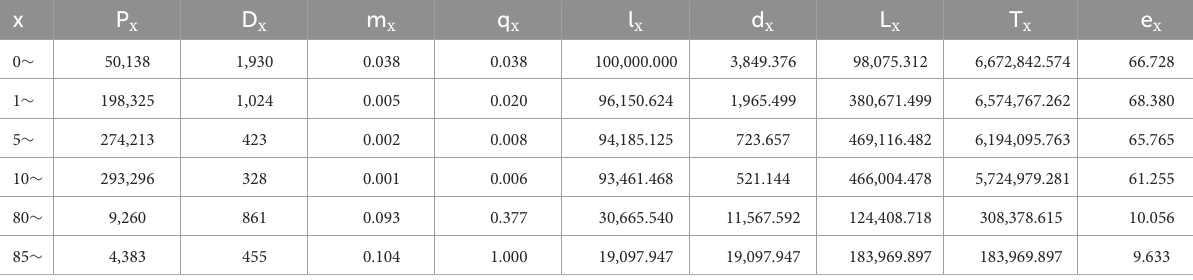
TABLE 1 Abbreviated life table for one region in